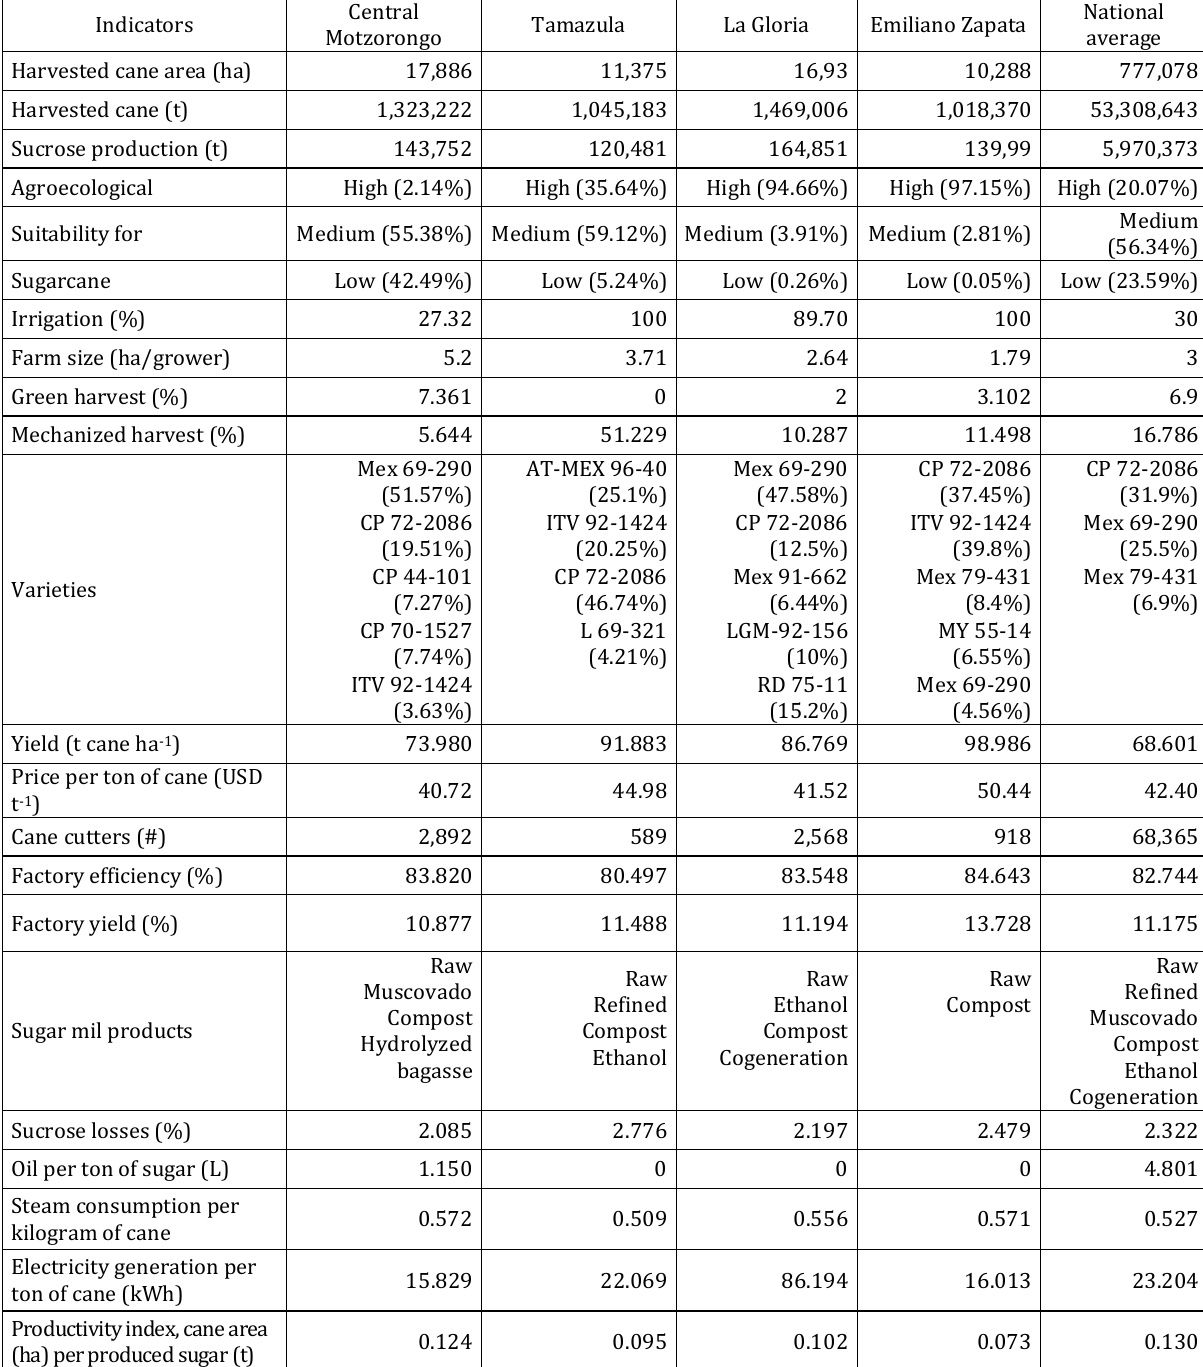
Table 1. Sugar mills considered in this study (data from Conadesuca, 2018) Indicators